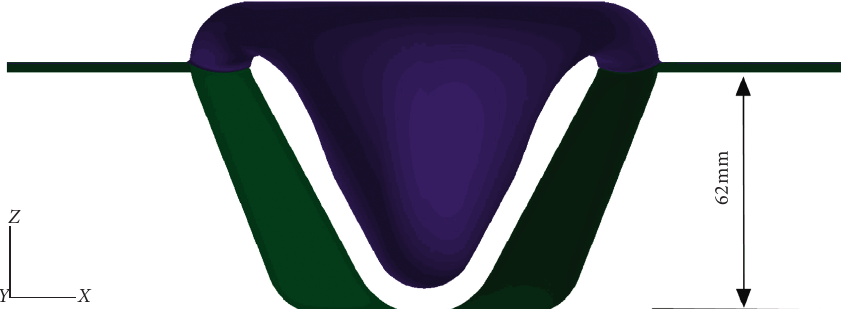
Figure 4: Location diagram of die parting line.